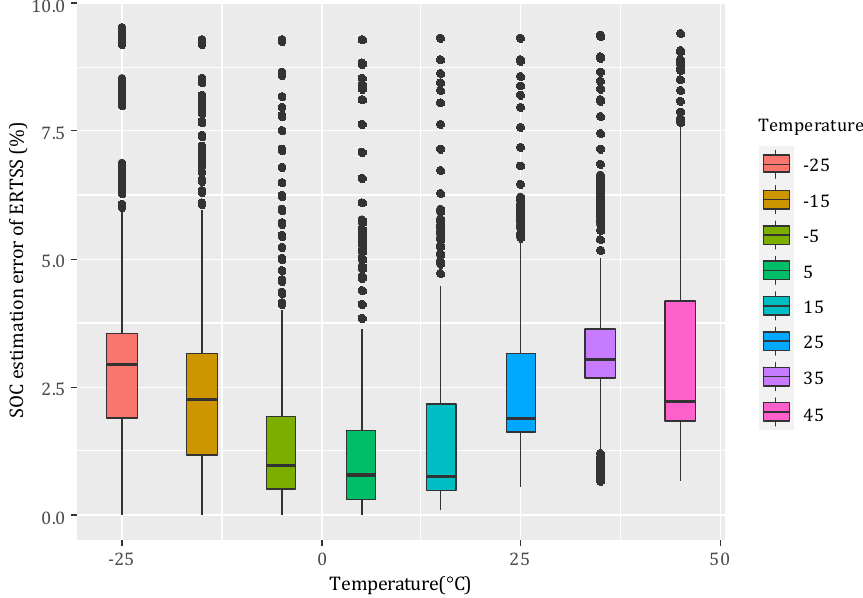
Figure 10. SOC estimation error of ERTSS at various